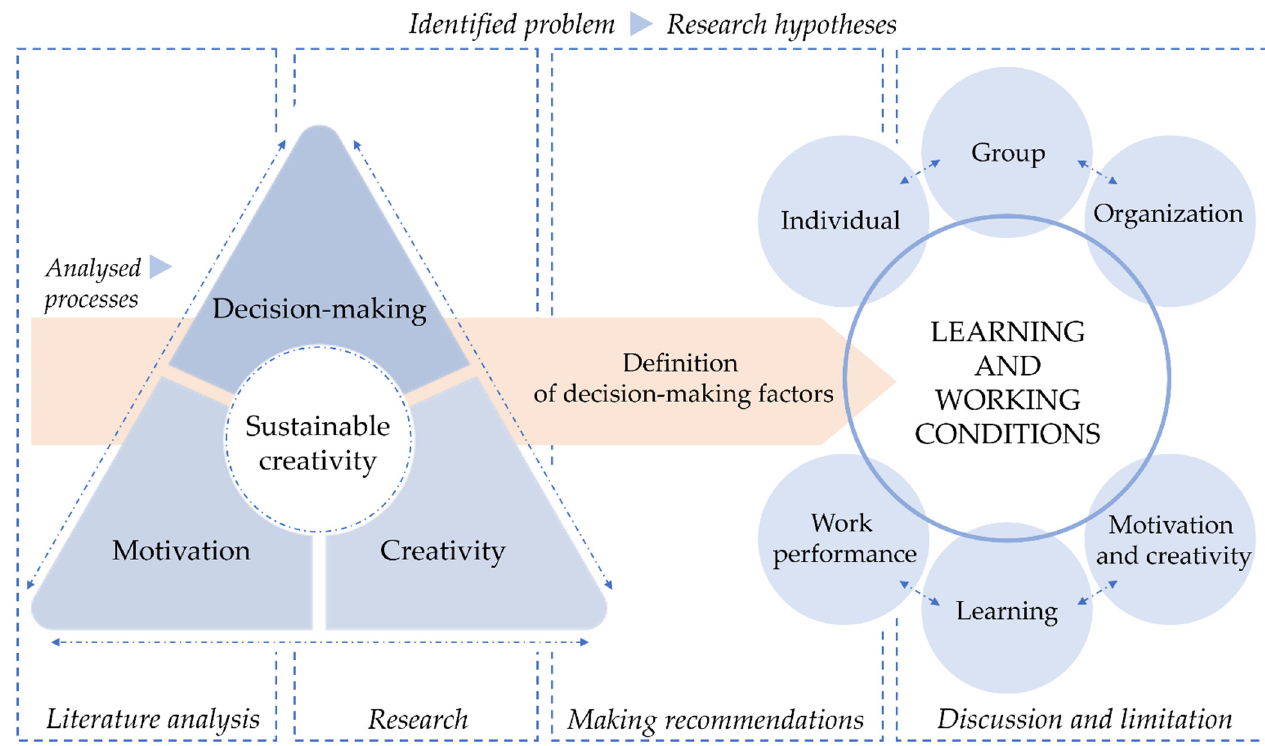
Figure 1. Mutual links between the research areas.